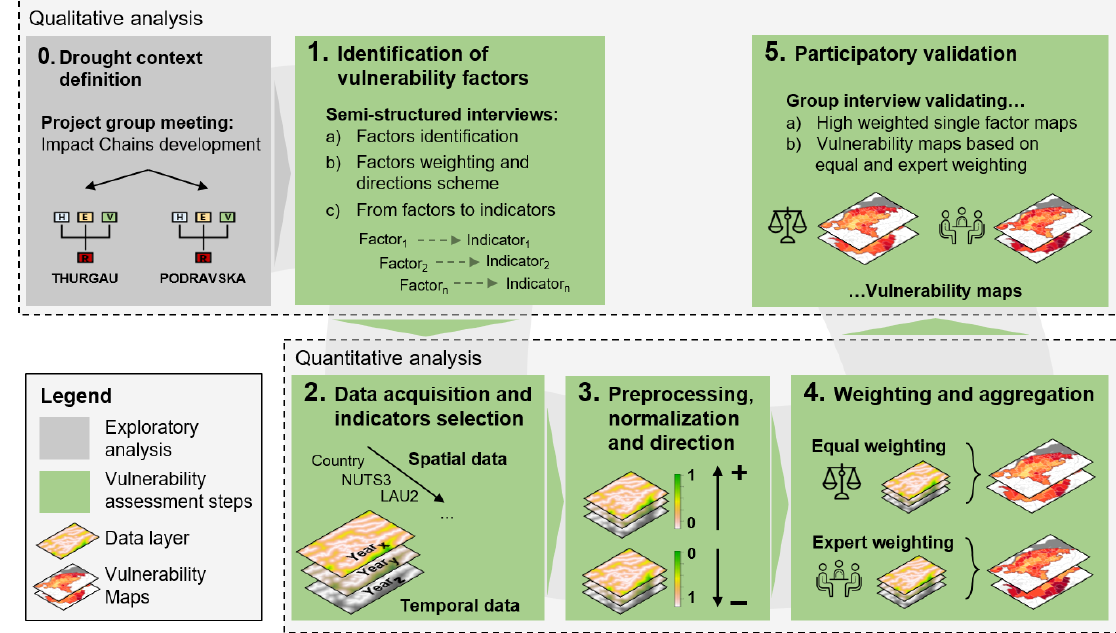
Figure 2. Conceptual overview of the methodological steps for the drought vulnerability assessment. The grey box represents the preliminary group discussion on agricultural drought while the green boxes refer to the five consequential phases for a spatial assessment of drought